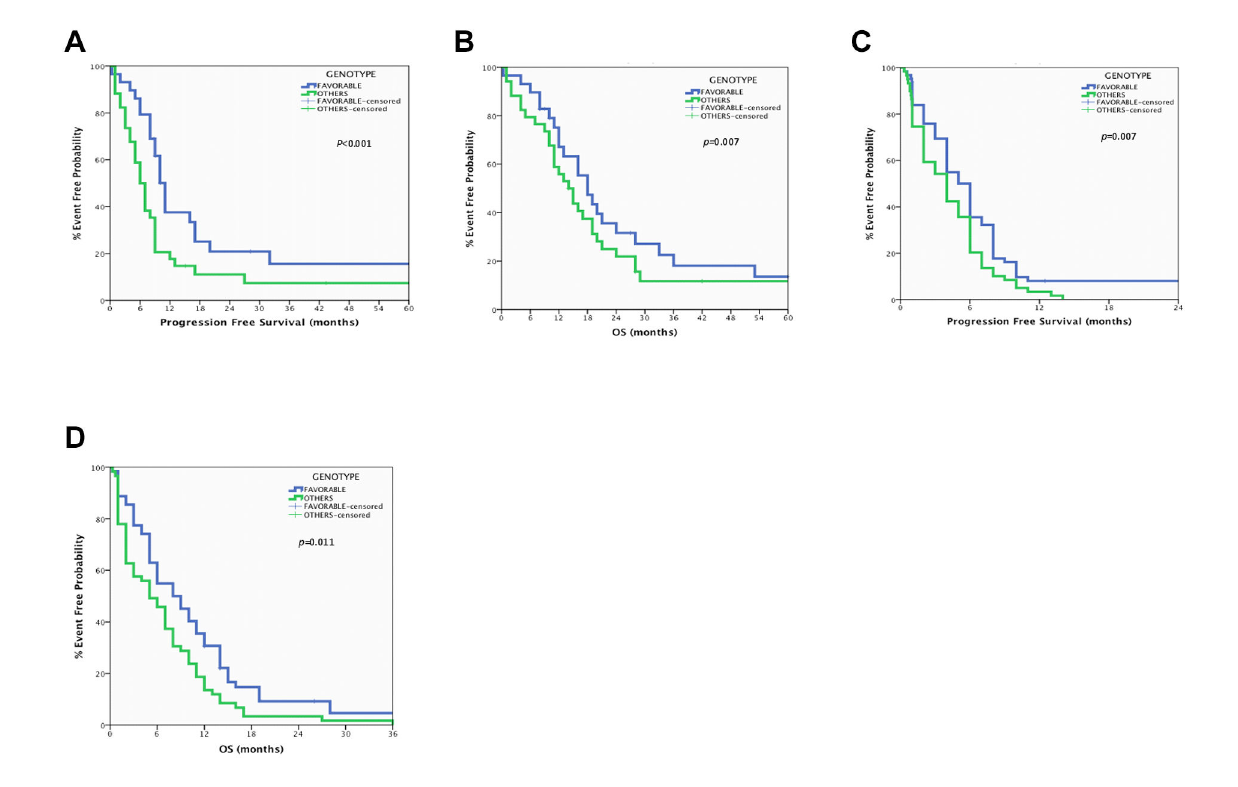
Figure 3. Predictive value of the expression signature (favorable: low ERCC1, PKM2, TOPOIIA and TOPOIIB mRNA levels) in SCLC. A. Correlation of expression signature with Progression Free Survival in Limited Stage-SCLC. B. Correlation of expression signature with Overall Survival in Limited Stage-SCLC. C. Correlation of expression signature with Progression Free Survival in Extended Stage-SCLC. D. Correlation of expression signature with Overall Survival in Extended Stage-SCLC. doi: